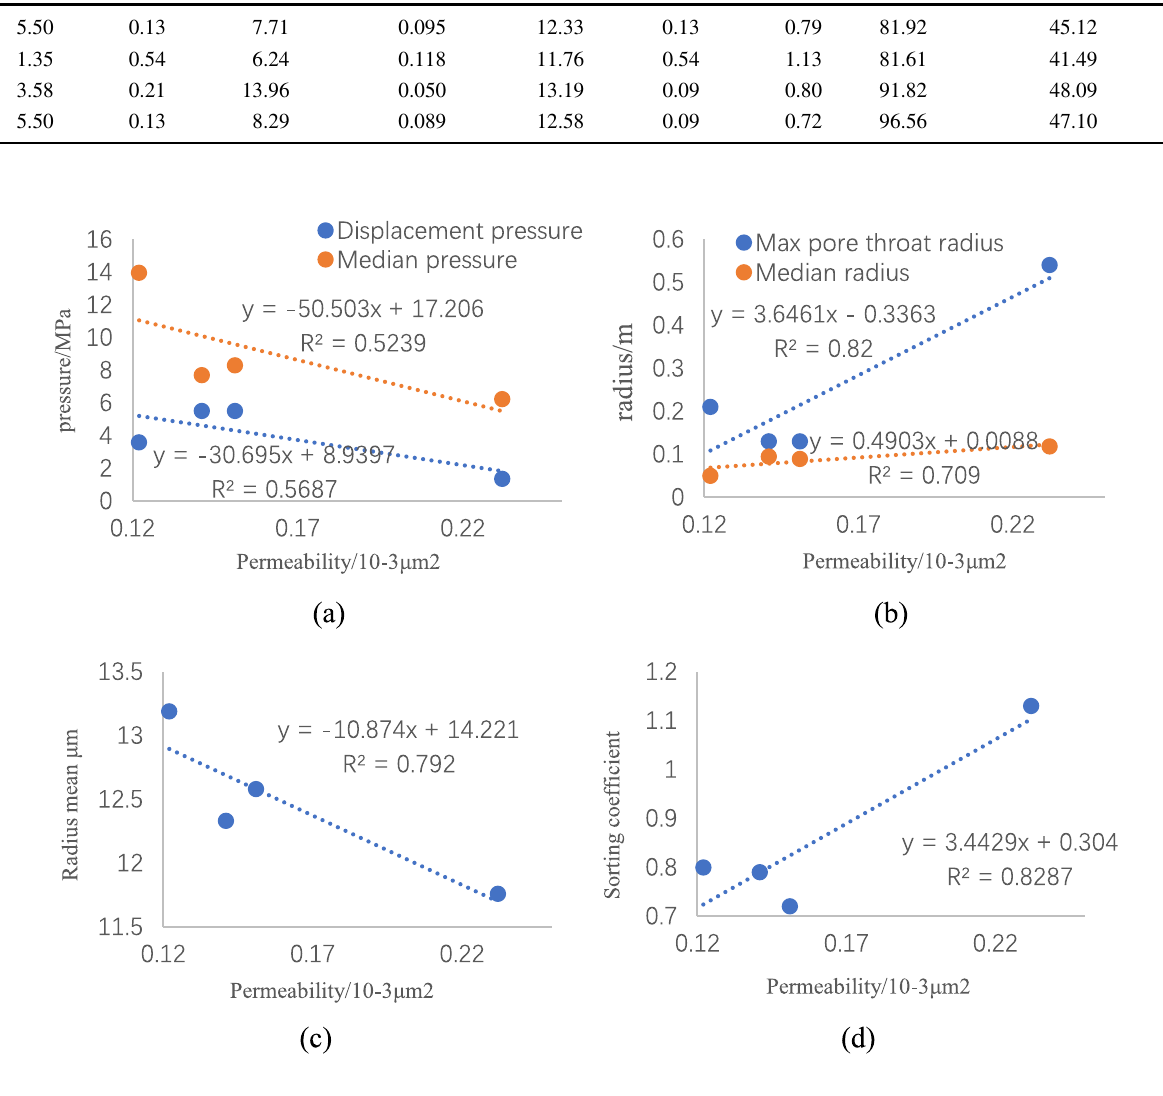
Fig. 3 Relationship between permeability and experimental results